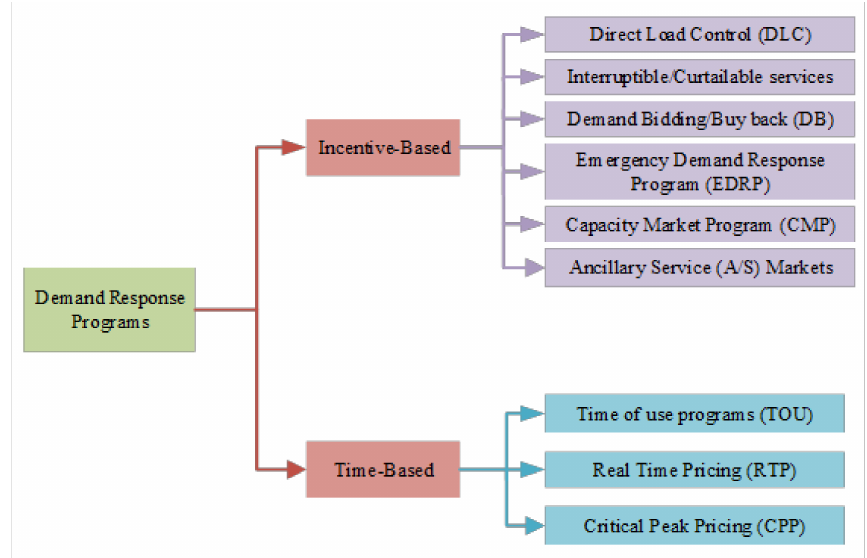
Figure 5. Classification of demand response program